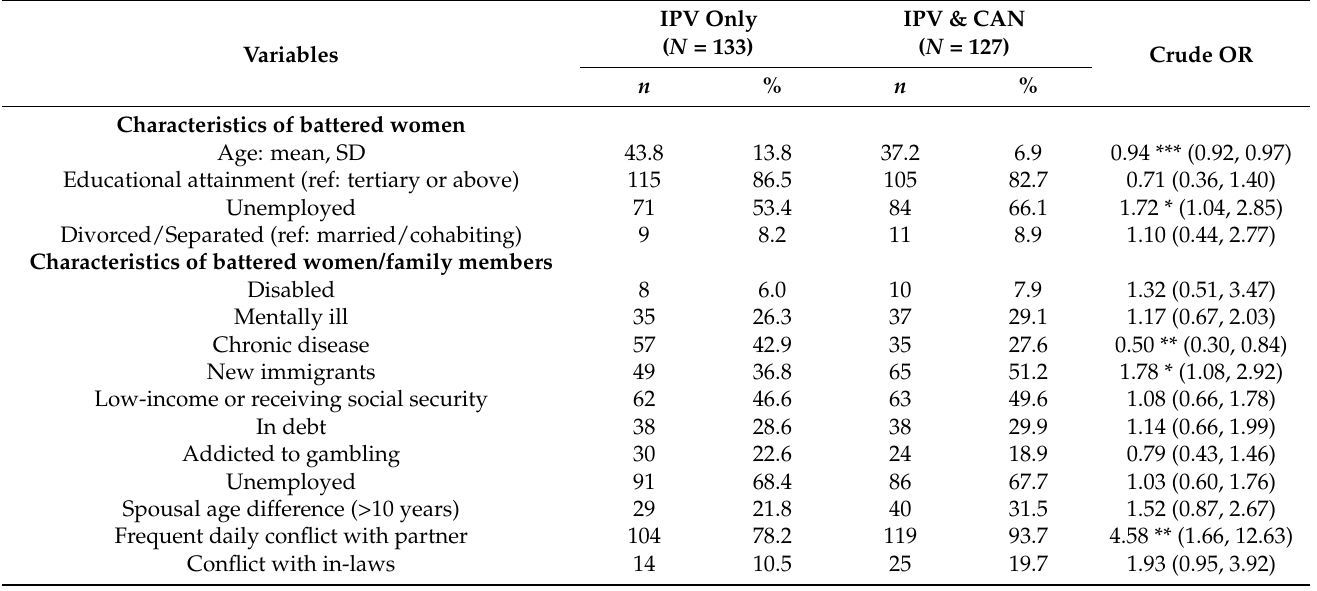
Table 5. Risk factors for